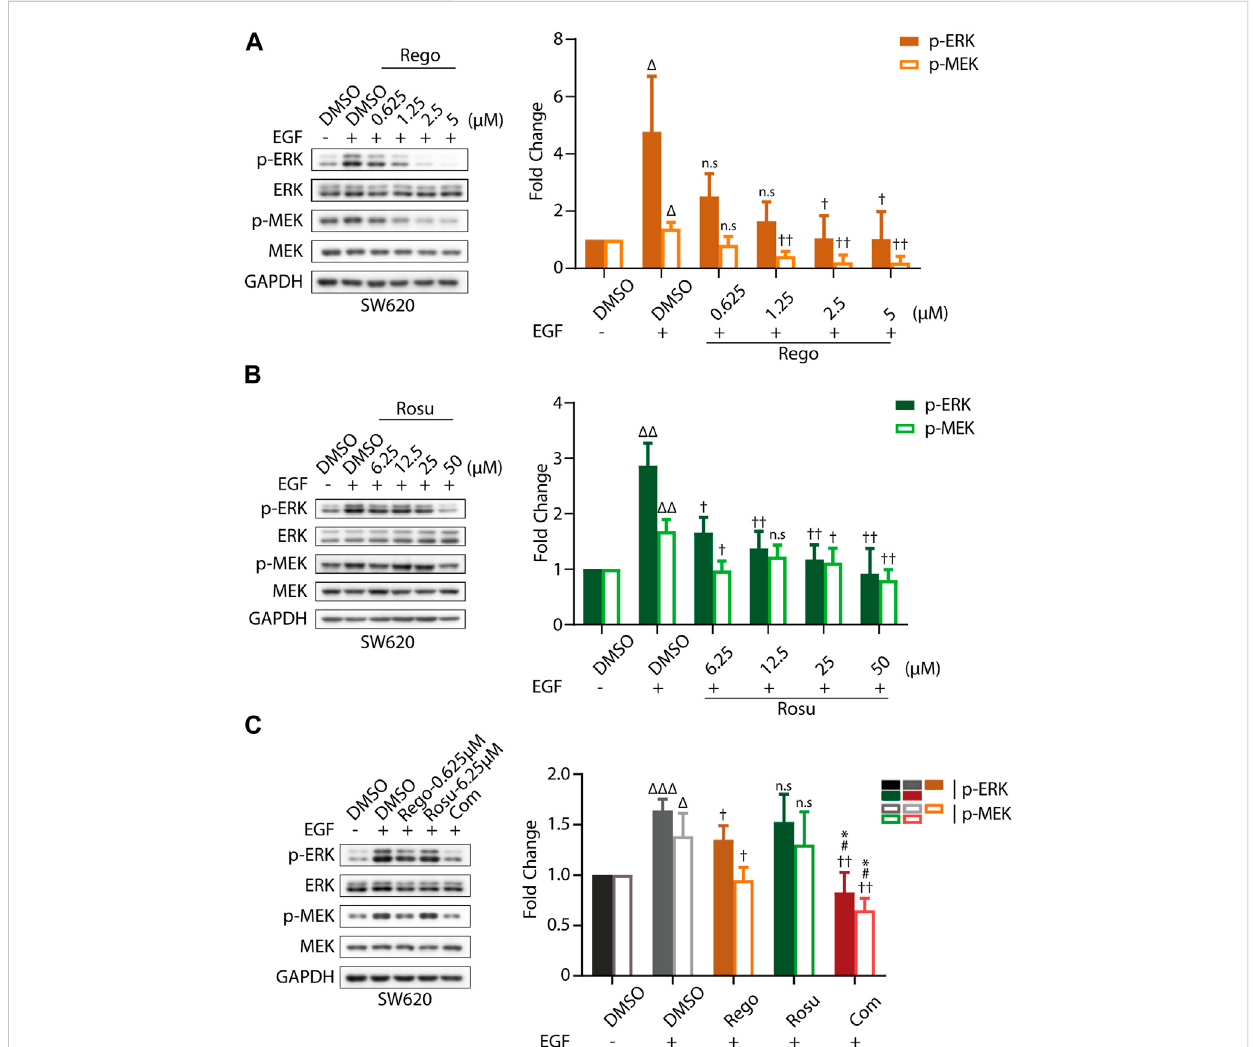
FIGURE 3 Regorafenib/rosuvastatin co-treatment exerted synergistical antitumor effect by inhibiting intrinsic MAPK signaling pathway. (A, B) Immunoblotting analysis to examine p-ERK/ERK and p-MEK/MEK expression levels in SW620 cells treated with regorafenib (range, 0.625 – 5 μ M) or rosuvastatin (range, 6.25 – 50 μ M). (C) Immunoblotting analysis to examine p-ERK/ERKand p-MEK/MEK expression levels in SW620 cells treated with regorafenib (0.625 μ M), rosuvastatin (6.25 μ M) and combinational treatment. SW620 cells were starved in serum-free RPMI-1640 media overnight and then treated with regorafenib/rosuvastatin or DMSO for 4 h. Before harvested, cells were treated with 500 ng/mL EGF for 30 min. The data are shown as mean ± SD of threereplicatesassays. n.s,no sense; † / Δ /*/#, † / p < 0.05; †† / ΔΔ , p < 0.01; ΔΔΔ , p < 0.001 ( † : vs . EGF+DMSOgroup; Δ : vs .DMSOgroup;*: vs. Regorafenib group; #: vs. Rosuvastatin group). Rosu: Rosuvastatin; Rego: Regorafenib; Com: